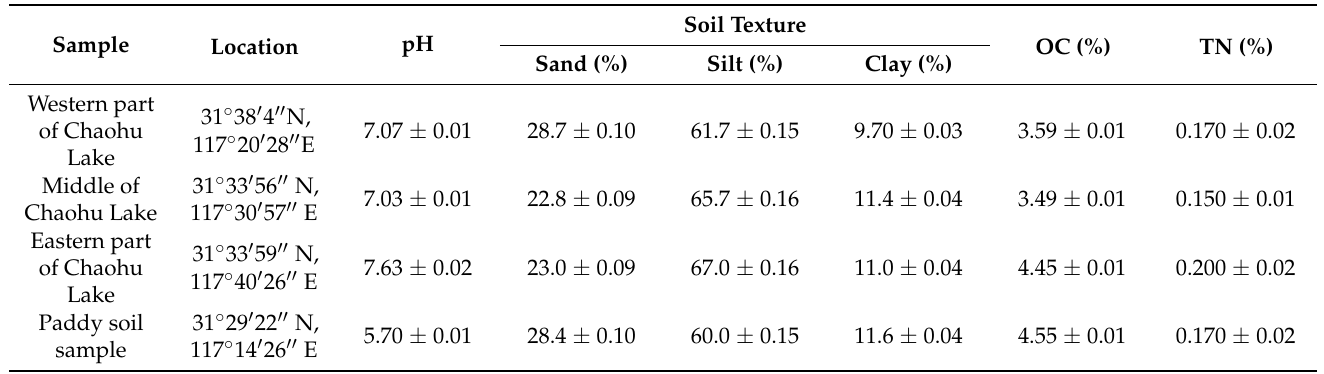
Table 1. Physicochemical properties of sediment and soil